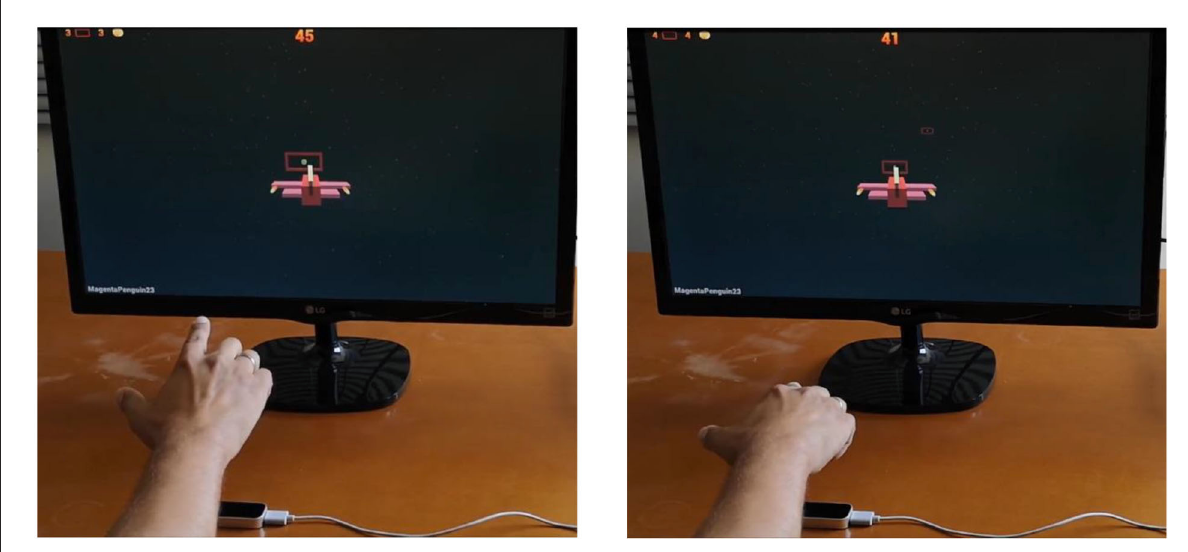
FIGURE6 Variant 3 of the game. The user can perform the rehabilitation exercises with the movement of his wrist and finger.